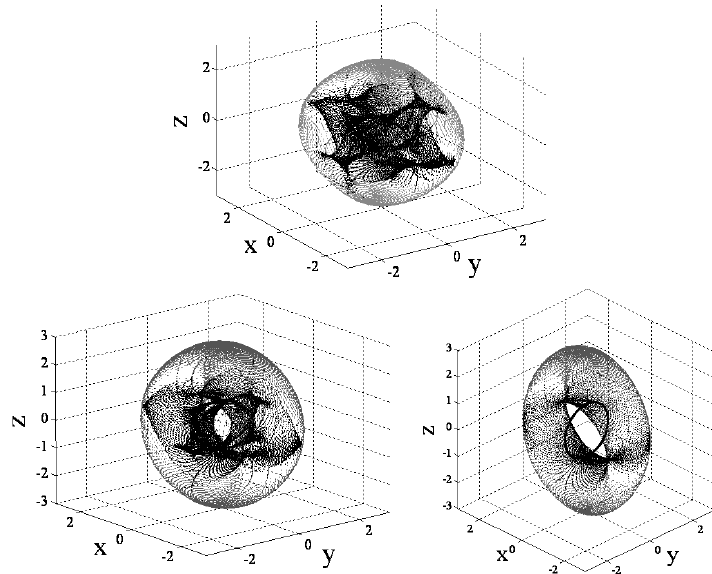
Figure 2. Heuristic analysis varying skew angle, β for a 3/4 CMG skewed array. Β was varied in 5° increments from 0° to 90° identifying the trend represented here by three primary plots with 3H &0H singular surface lightened to enable visualization of 1H & 2H singular surfaces: β = 70 ° ( top ), 80 ° ( lower left ), 90° ( lower right ).